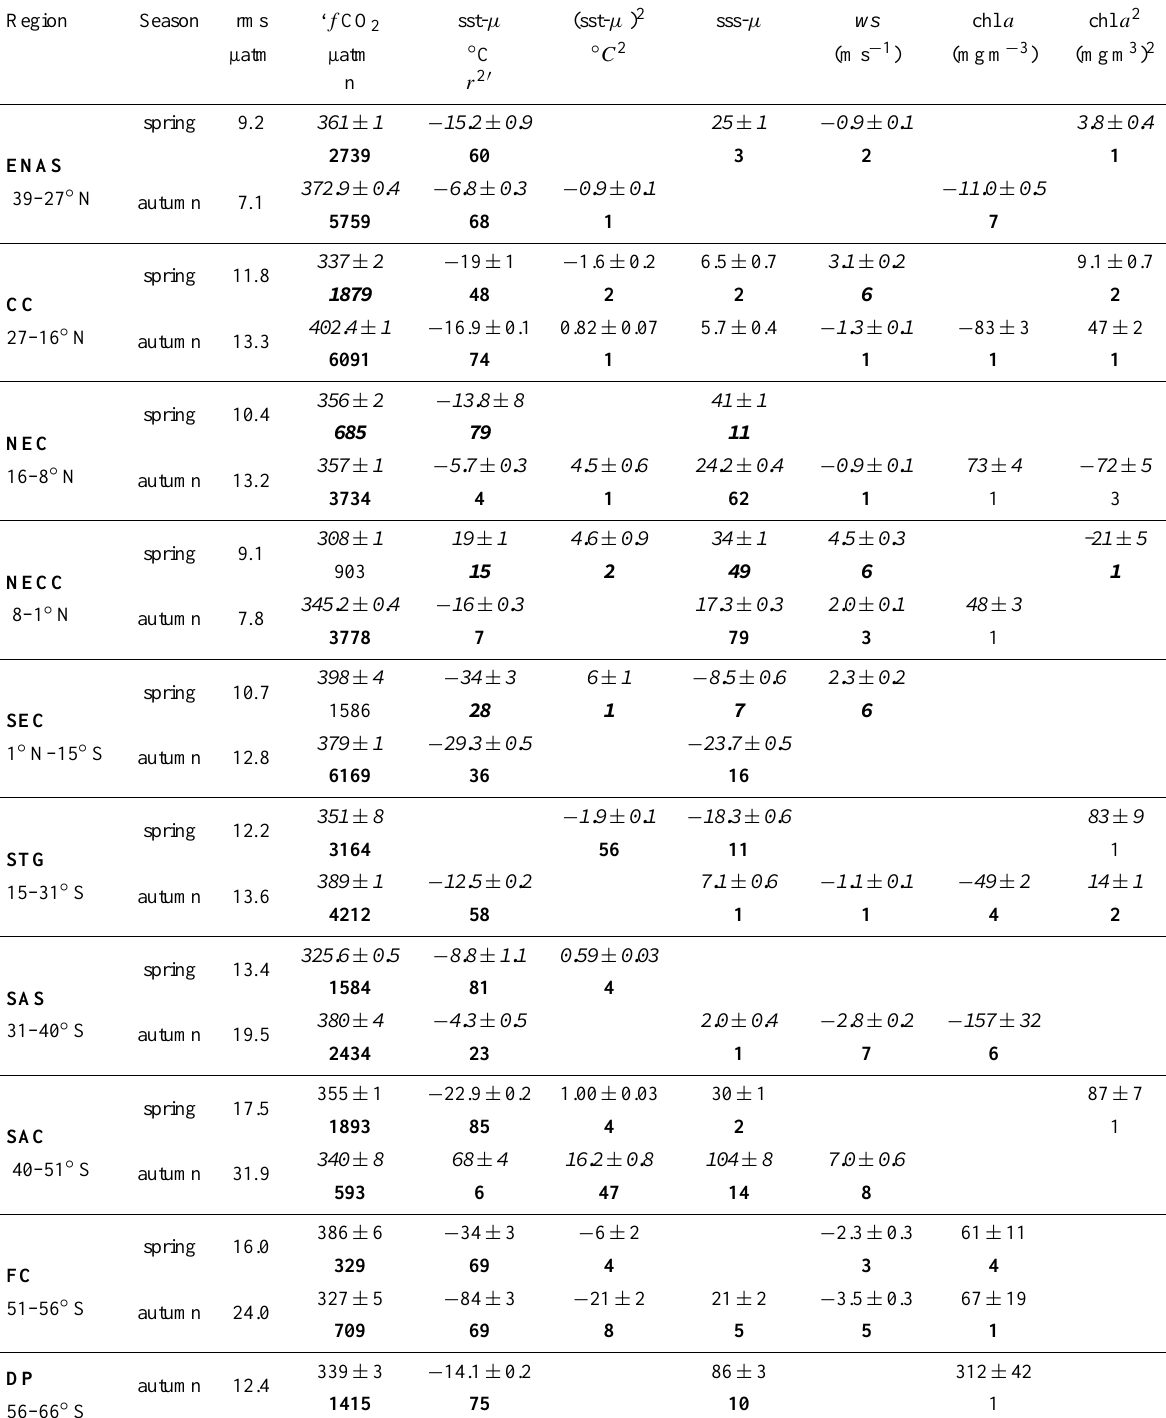
Table 3. Regression coefficients (in italics) and variability explained (bold-faced) by each of the parameters included in the empirical algorithm given in equation (4) applied in every biogeochemical province where f CO sw and the correlation coefficient ( r 2 ) are also given. The “n” value stands for the number of valid data included in each